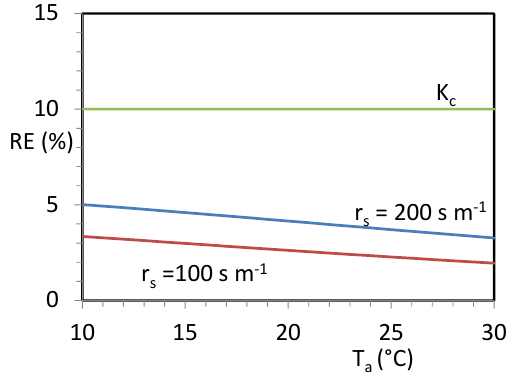
Figure 2. Relative error on crop evapotranspiration ET c (RE = 100 δ ET c / ET c ) as a function of air temperature ( T a ) for a 10% error on crop coefficient K c (two-step approach) or on surface resistance r s (one-step approach) with z h = 1m and u a = 2ms − 1 .